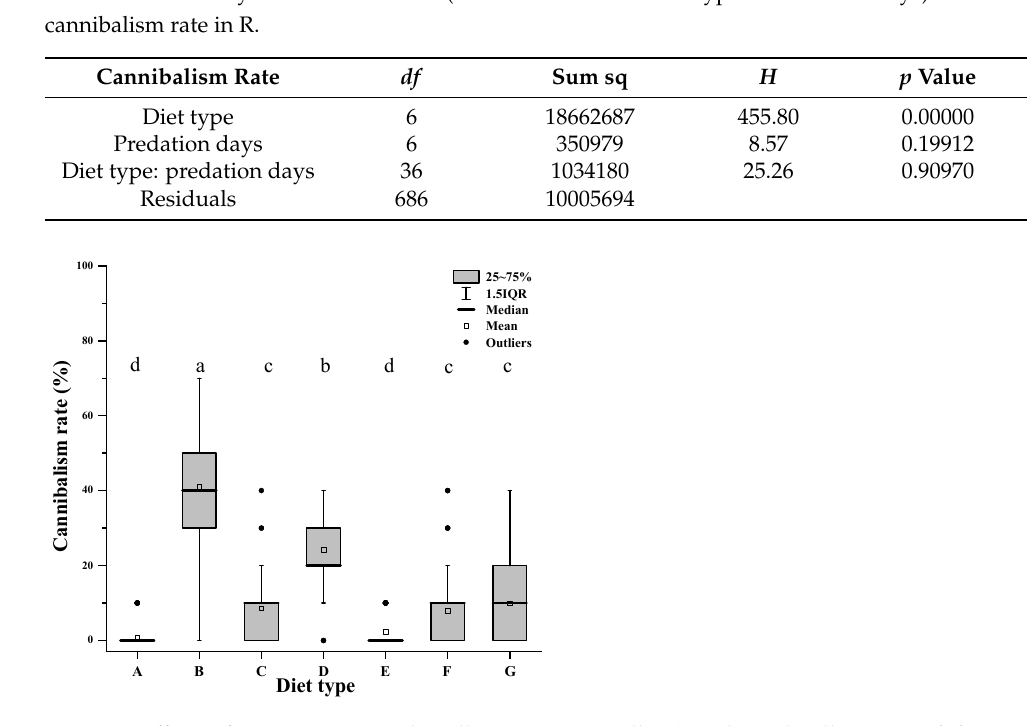
Figure 4. Effects of T. urticae (A), apple pollen (B), maize pollen (C), almond pollen (D), O. bakeri (E), T. putrescentiae (F), and A. ovatus (G) on the cannibalism of A. herbicolus . Different letters (a–d) showed the presence of significant differences following the Kruskal–Wallis H test ( p < 0.05).